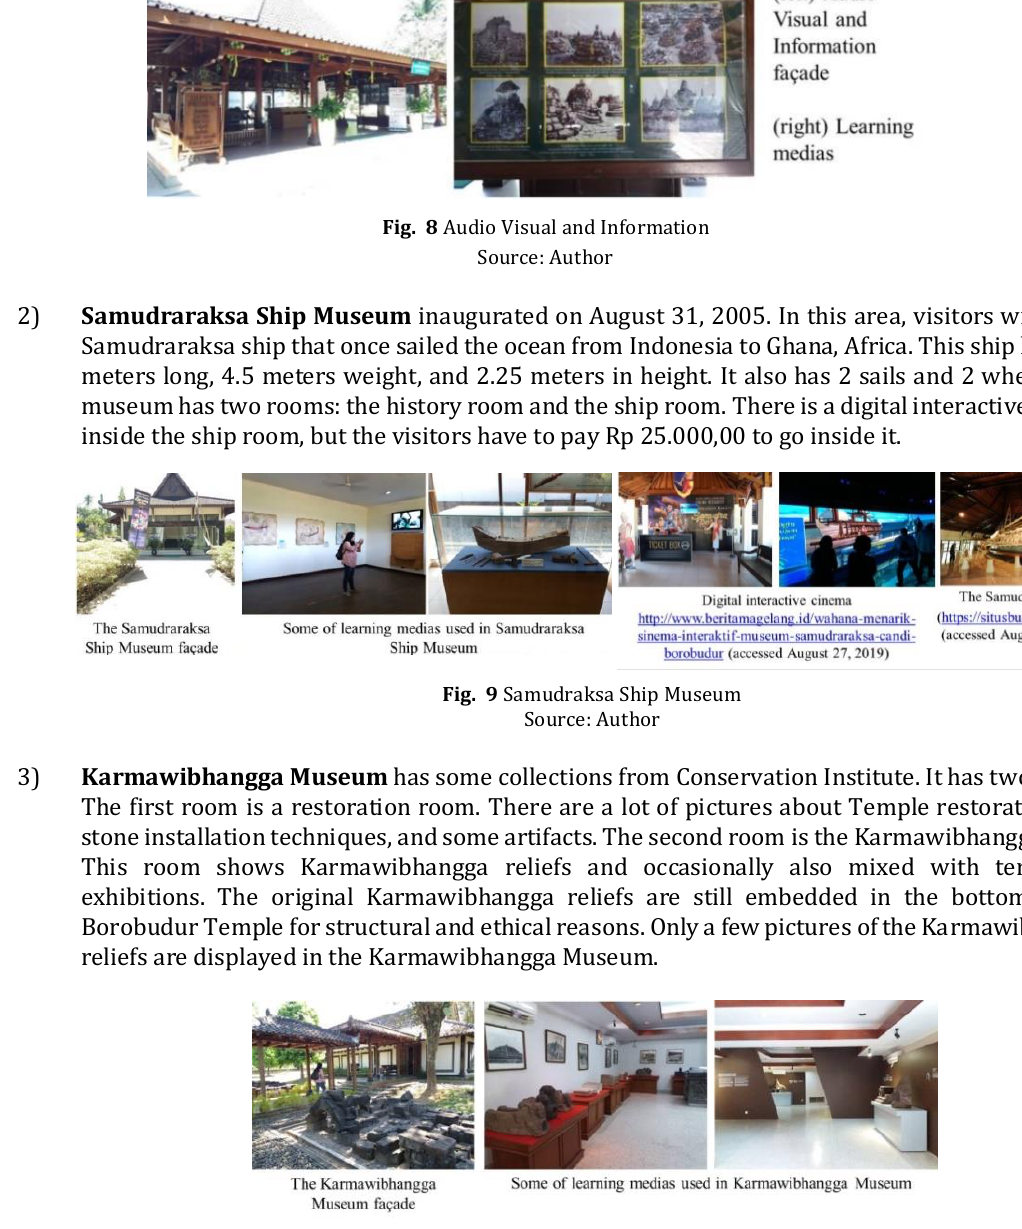
Fig. 10 Karmawibhangga Museum